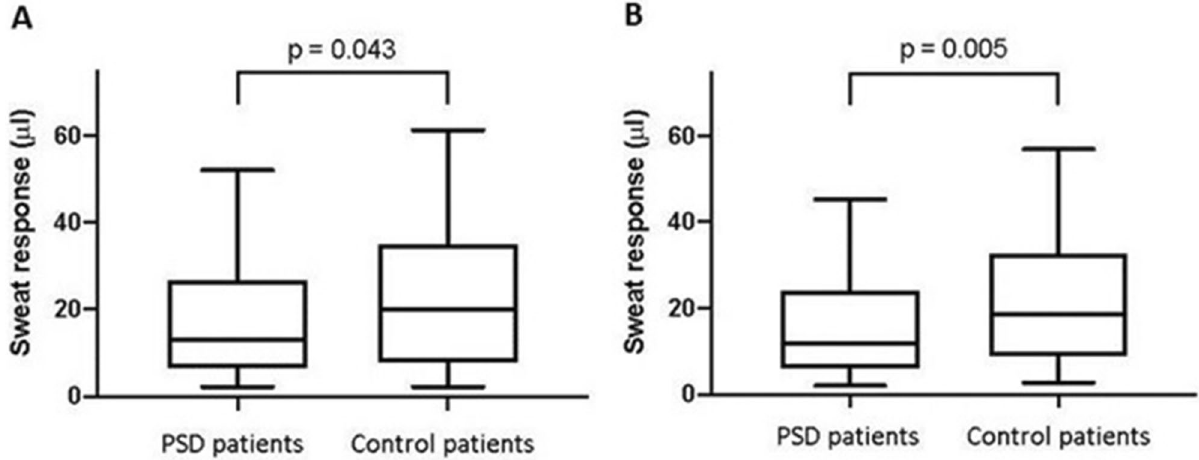
Figure 2. Sweat response in a manually and propensity score matched comparison. Box-and-Whisker plots of the primary outcome (sweat response) in the manually matched (panel 2 A ) and propensity score matched (panel 2 B ) cohorts. The boxes show the medians and quartiles, while the whiskers extend from the 5th to the 95th percentile. p values are based on the Wilcoxon signed-rank